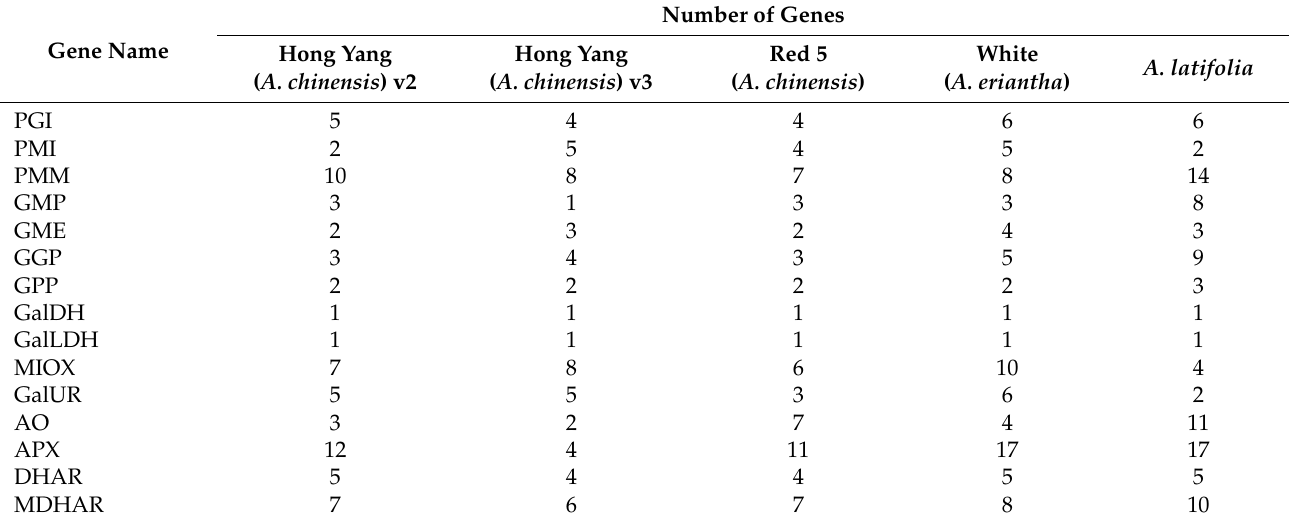
Table 3. Comparison of the number of gene families involved in the biosynthesis and recycling pathway of ascorbic acid in different kiwifruit